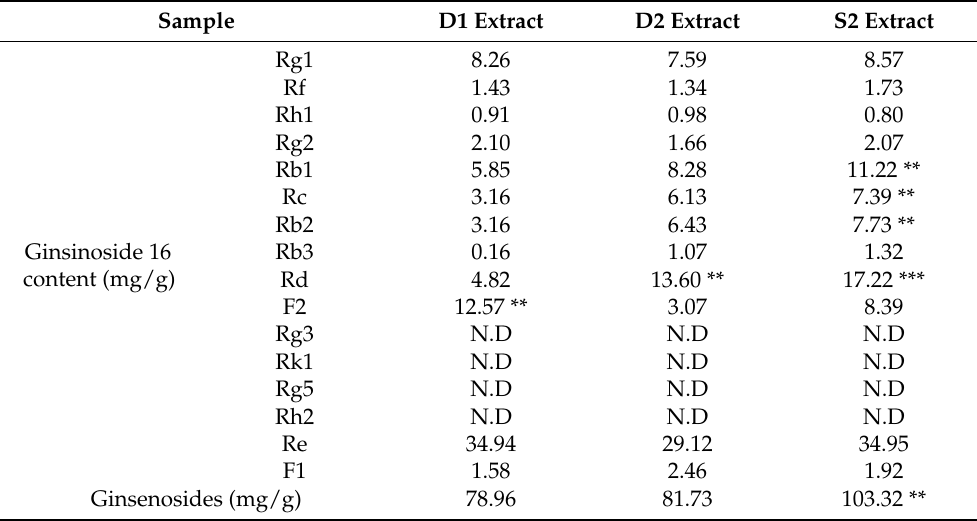
Table 1. Compositional analysis of ginsenosides of P. ginseng